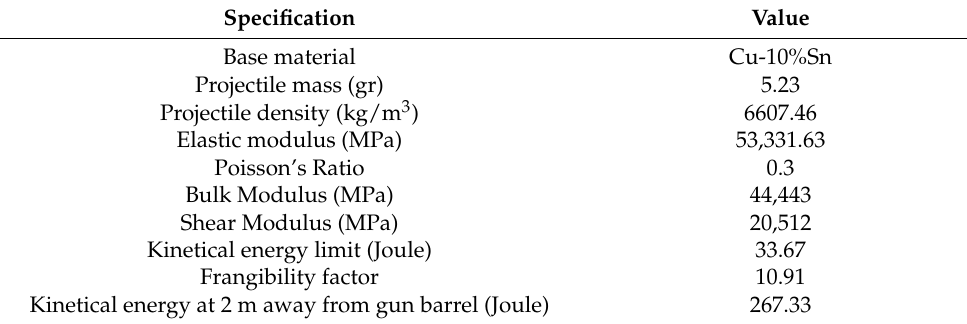
Table 2. AMMO 2 spesification.